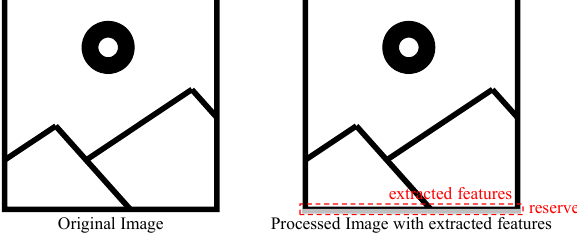
Figure 8. Original and processed images.